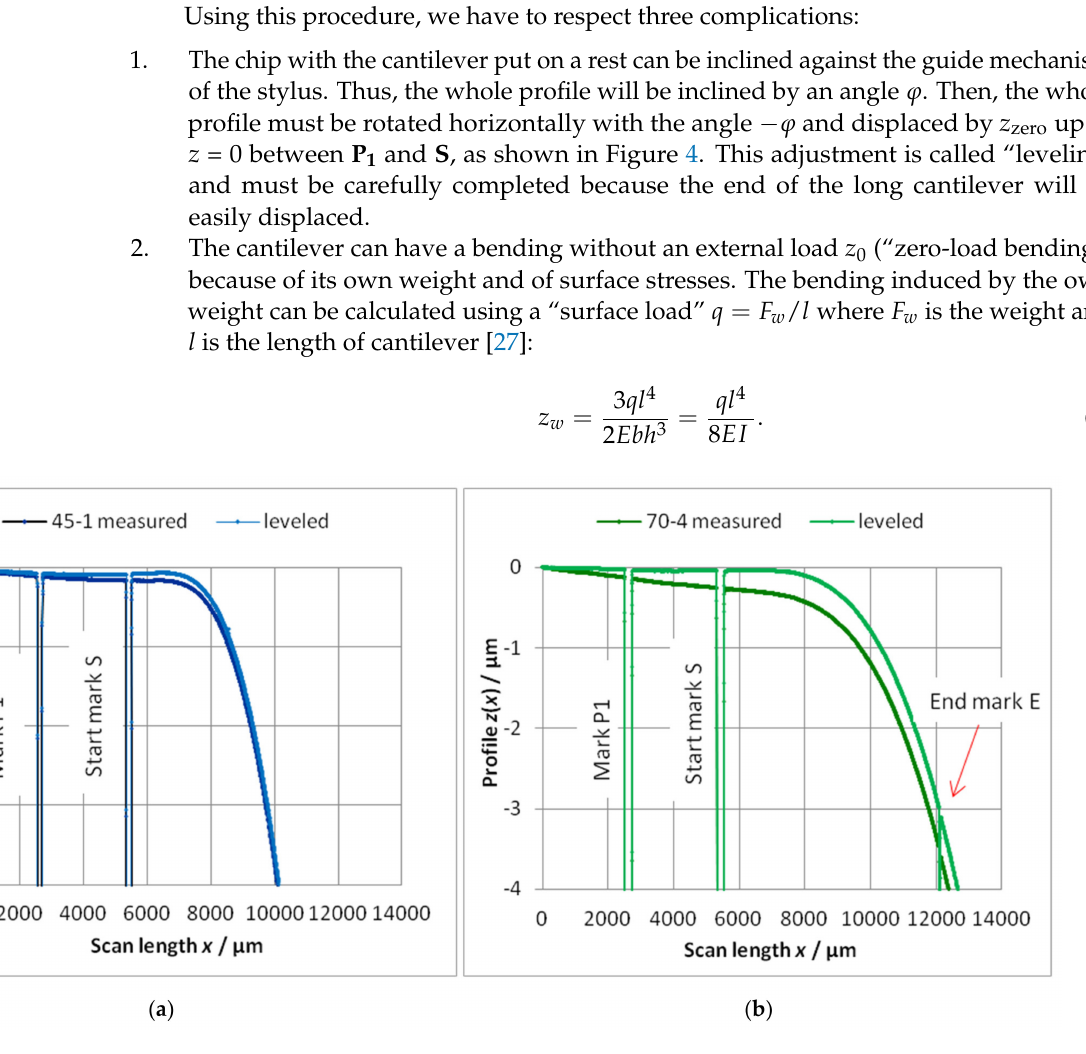
Figure 4. These figures show the profiles measured on the cantilevers ( a ) 45-1 (blue) and ( b ) 70-4 (green). Dark: The profile as measured. Bright: The profile rotated (single-end approach, see Figure 5) by the angle ϕ determined between the marks P 1 and S . Hereafter, the bending line is slightly displaced by z zero to the negative direction by the procedure of rotation. A shift of the profile up to z zero = 0 must follow (the combination of the procedures rotation and shift is called “leveling”. Then, the bending line begins at approximately z = 0 with a slope of zero. The specification of the cantilevers 45-1 and 70-4 are given in Section